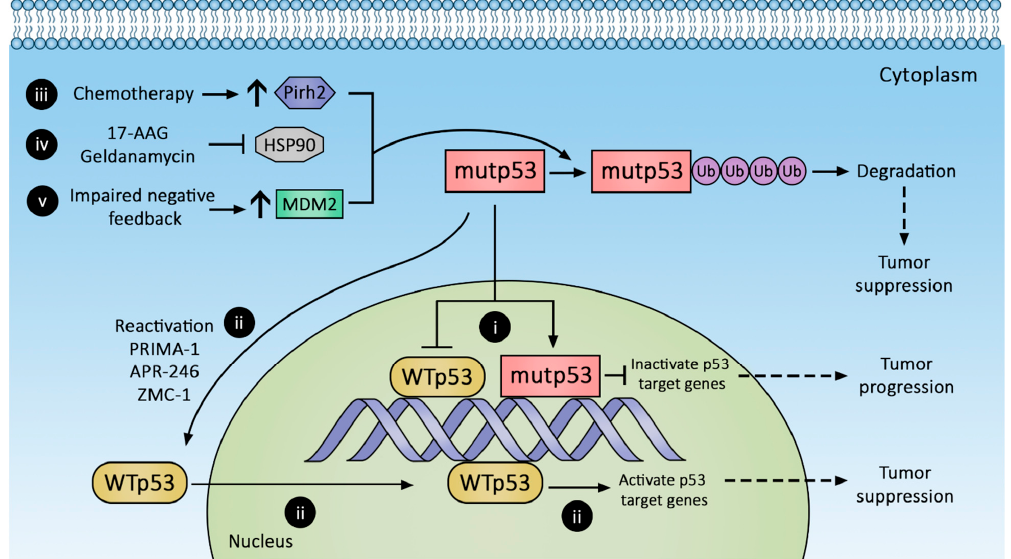
Figure 2. Therapeutic strategies against p53 mutants (mutp53). Mutp53 promotes CRC progression, whereas reactivation and decreased mutp53 suppress CRC. Mutp53 inactivation of p53 target